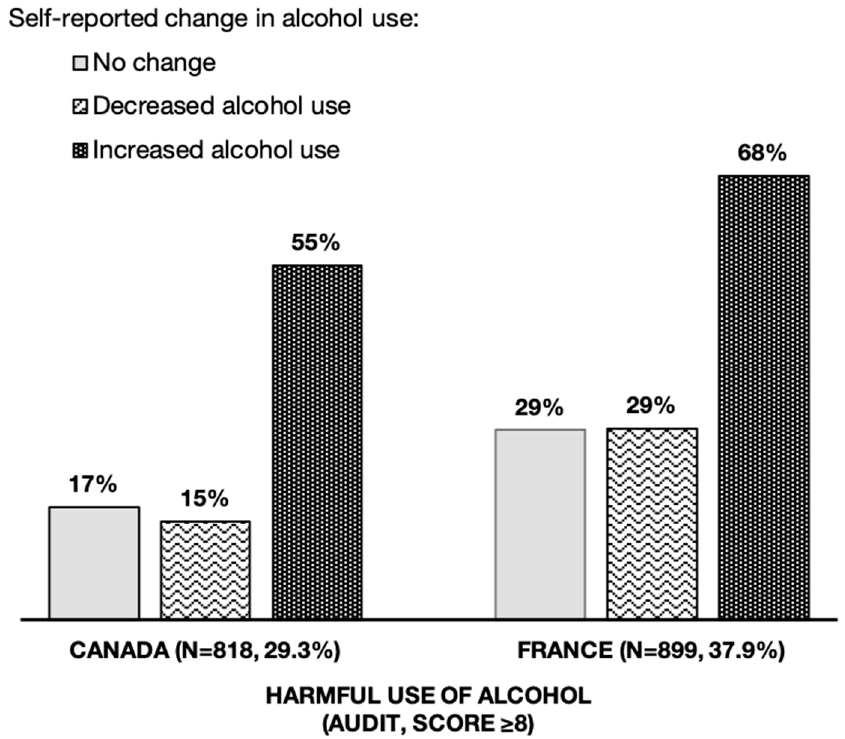
Figure 1. Self-reported change in alcohol use in the last 6 months and harmful use of alcohol among young adults in Canada ( n = 2793) and France ( n = 2392).